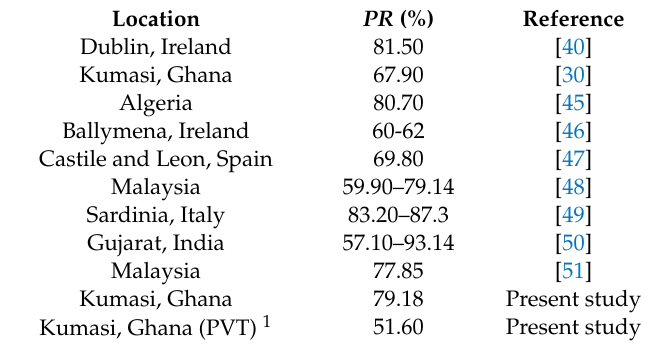
Table 5. Performance parameter for mc-Si modules in the